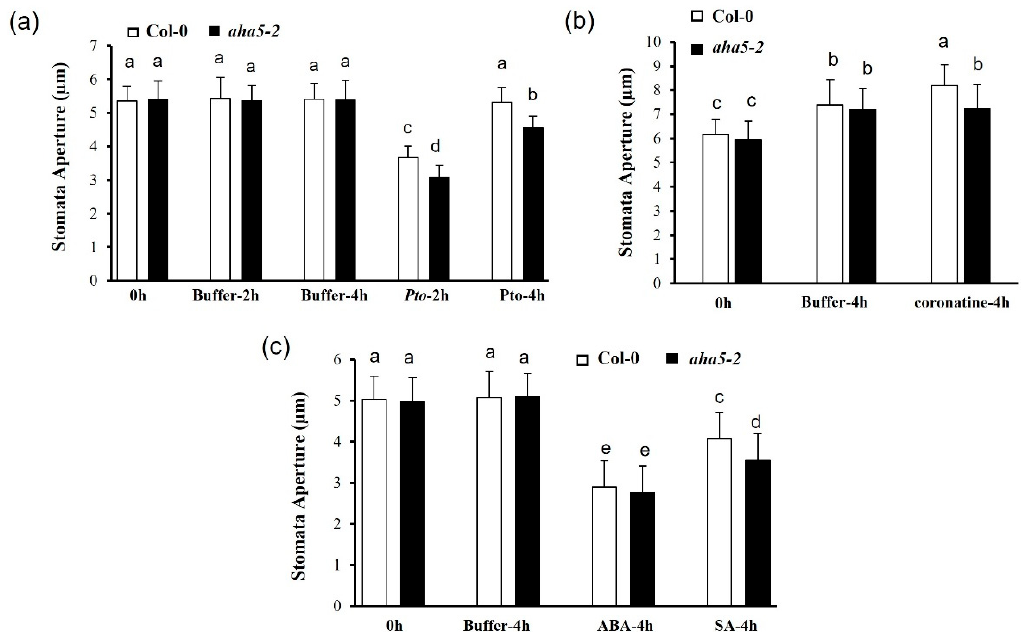
Figure 5. AHA5 is involved in the stomatal movement upon the pathogen and hormone treatments. ( a ) The aha5-2 mutant showed the enhanced stomatal closure against the Pto pathogen. At the six-week-old stage, the aha5-2 mutant and WT Col-0 leaves were treated with the cell suspension (10 8 CFU/mL) of the virulent strain Pto DC3000. The stomatal apertures were checked with microscopy at 0 h, 2 h, and 4 h after the pathogen infection with the abaxial epidermis peels. ( b ) The aha5-2 mutant plants did not respond to the coronatine treatment as the WT plants did. The aha5-2 mutant and WT Col-0 leaves at the six-week-old stage were placed in the buffer or buffer containing 1 ng/ µ L coronatine. Stomatal apertures were checked with microscopy at 0 h and 4 h after the treatments. ( c ) The aha5-2 mutant plants displayed the SA-induced stomatal closure compared to the WT plants. The aha5-2 mutant and WT Col-0 leaves at the six-week-old stage were treated with 50 µ M ABA, 500 µ M SA, or MES buffer. The stomatal apertures were checked at 0 h and 4 h after the treatments. All the experiments related to stomata regulation with different treatments were repeated three times with similar results. The data represent means ± SE (n = 50), which are from one of the three independent repeats. Different letters a–e within the figures ( a – c ) indicate significant differences at p < 0.05, which was calculated by a one-way analysis of variance (ANOVA) using SPSS ver. 21. (IBM SPSS Statistics, New York, NY,